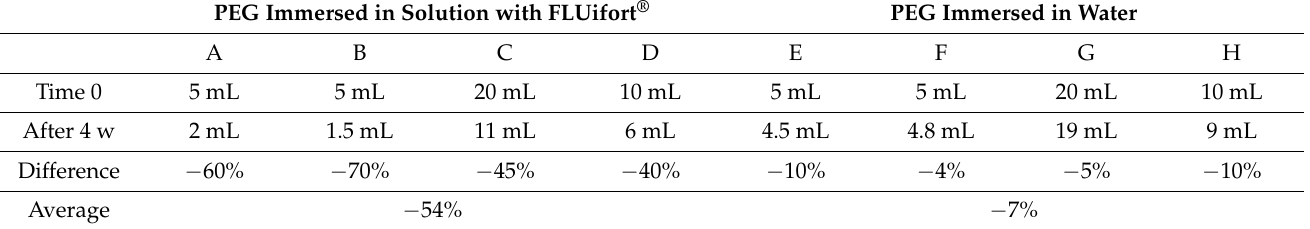
Table 1. Percentage of balloon deflation observed in devices immersed in carbocysteine lysine salt syrup (FLUifort ® ) and distilled